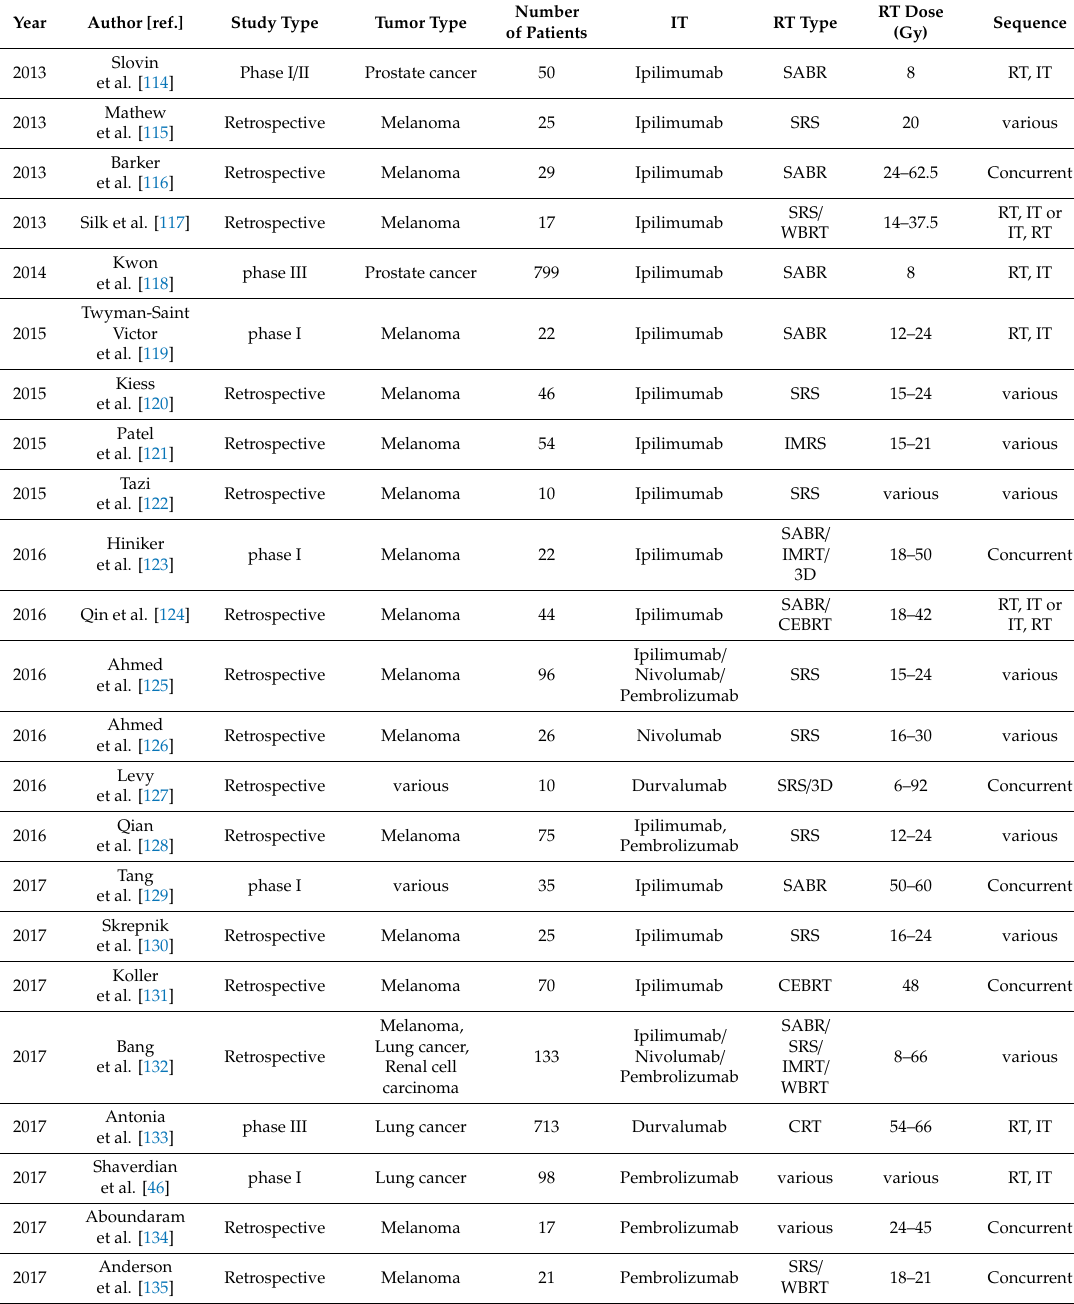
Table 1. Selected studies using combinations of radiotherapy and